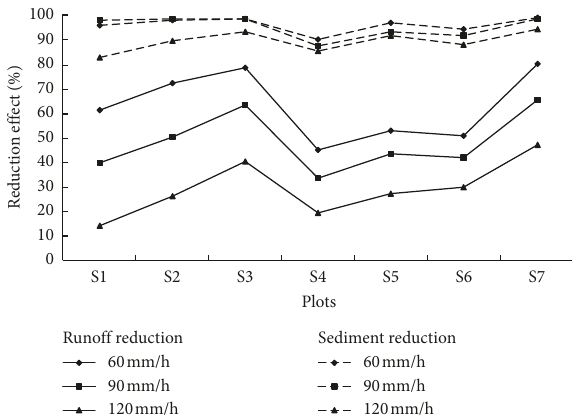
Figure 5: Runoff and sediment reduction effects under different vegetation covers and rainfall